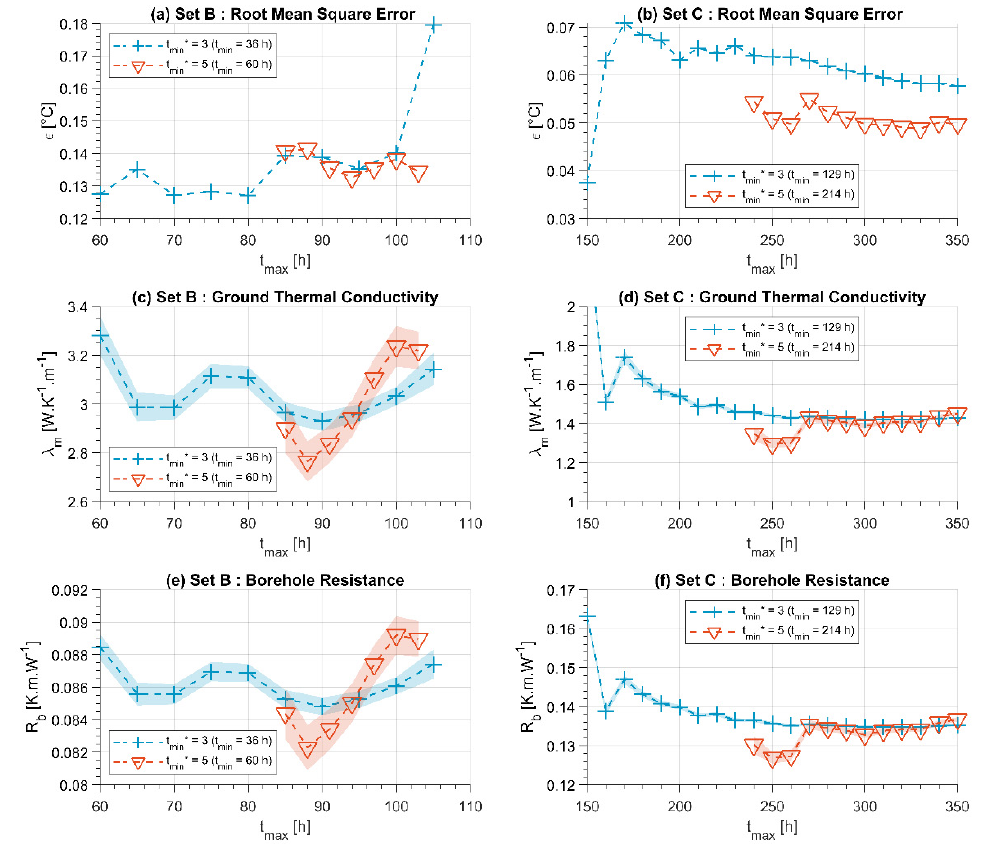
Figure 5. Classical interpretation of TRT: values of ε , λ m and R b as a function of the duration of the integration t max : misfit ε for ( a ) set B, ( b ) set C; λ m for ( c ) set B, ( d ) set C, R b for ( e ) set B, ( f ) set C. The stripe represents the 95% confidence interval on the fitted parameter.